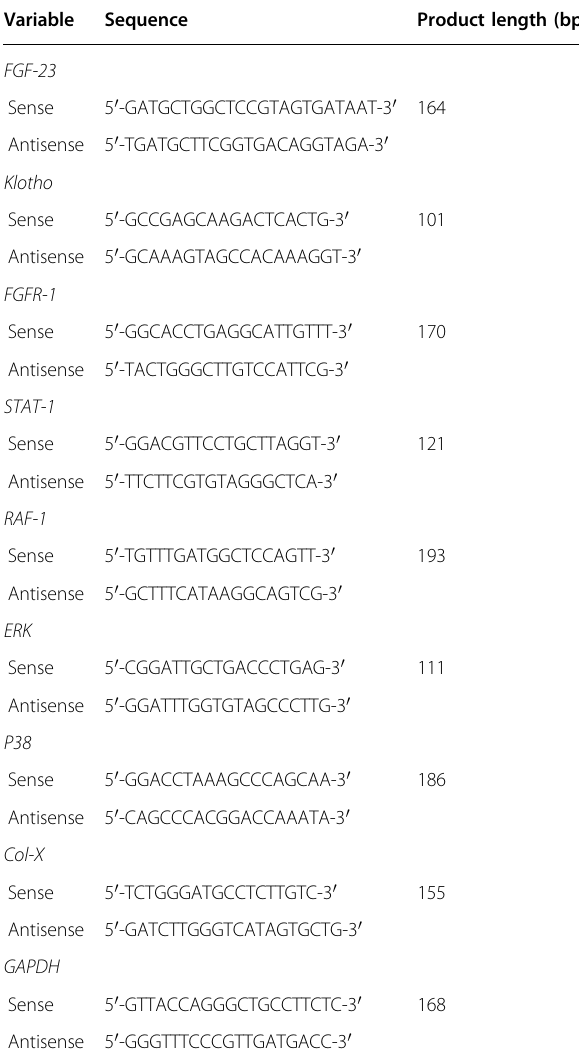
Table 1 List and sequence of